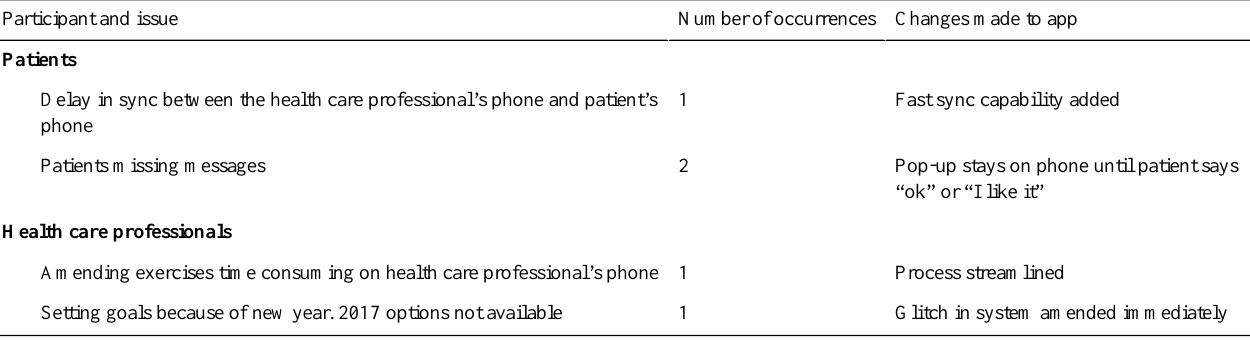
Table 1. Issue log data.